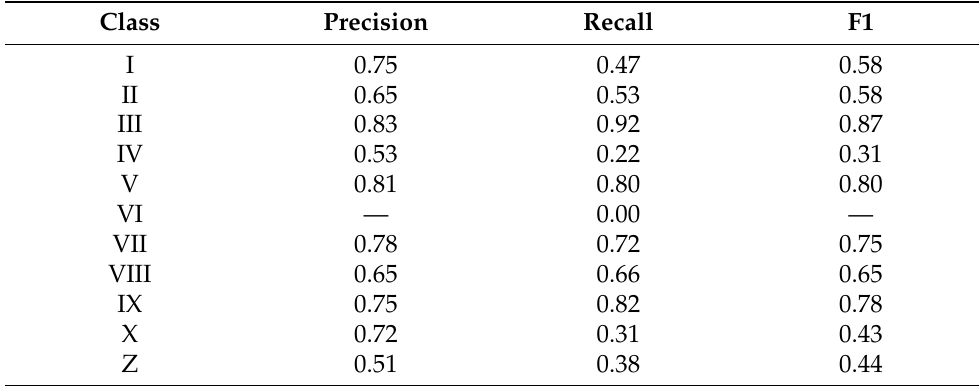
Table 6. Economic activity prediction precision and recall per class (top-1).